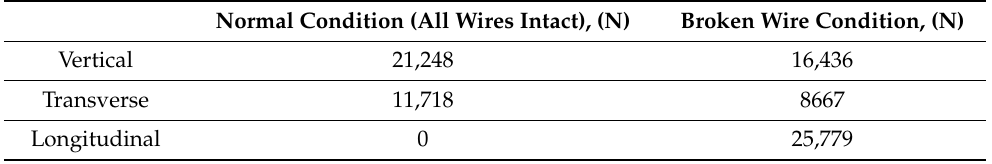
Figure 6. Working load applied in GFRP cross-arm. Table 3. Working load (WL) for 24 L GFRP cross-arm in 275 kV transmission tower for normal and broken wire